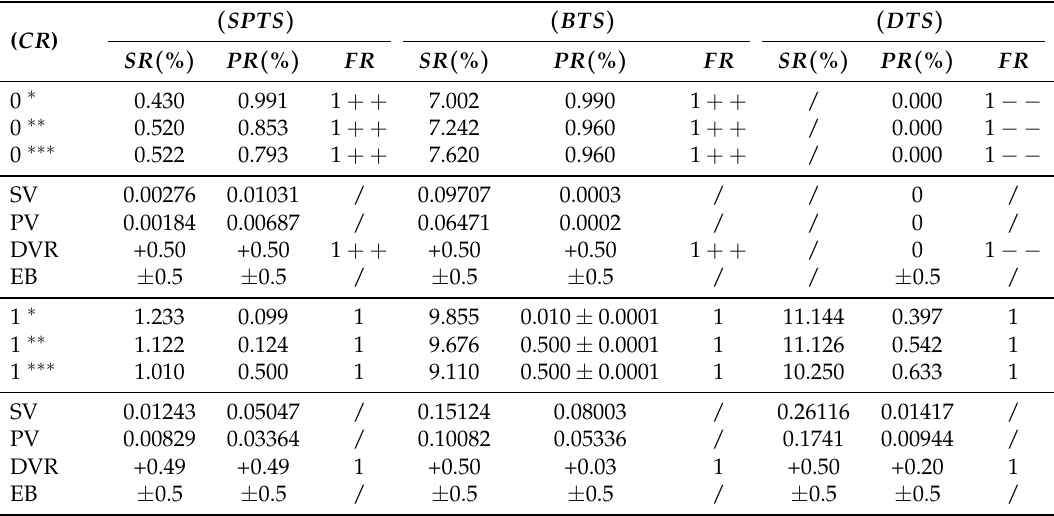
Table 4. Quantum simulation of high-dimensional data tables describing the three topological structures of the DE algorithm implied in β -Hilbert space about CR